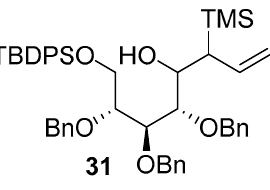
Figure 11. The structure of silanol 31.